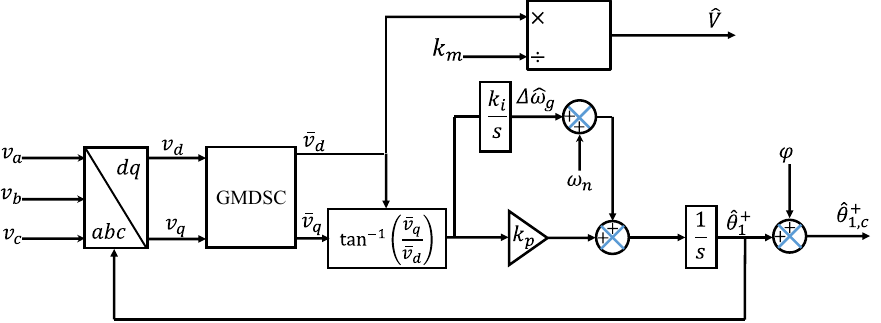
Figure 4. Block diagram of the proposed PLL, where GMDSC is the generalized delayed signal can- cellation block. cancellation